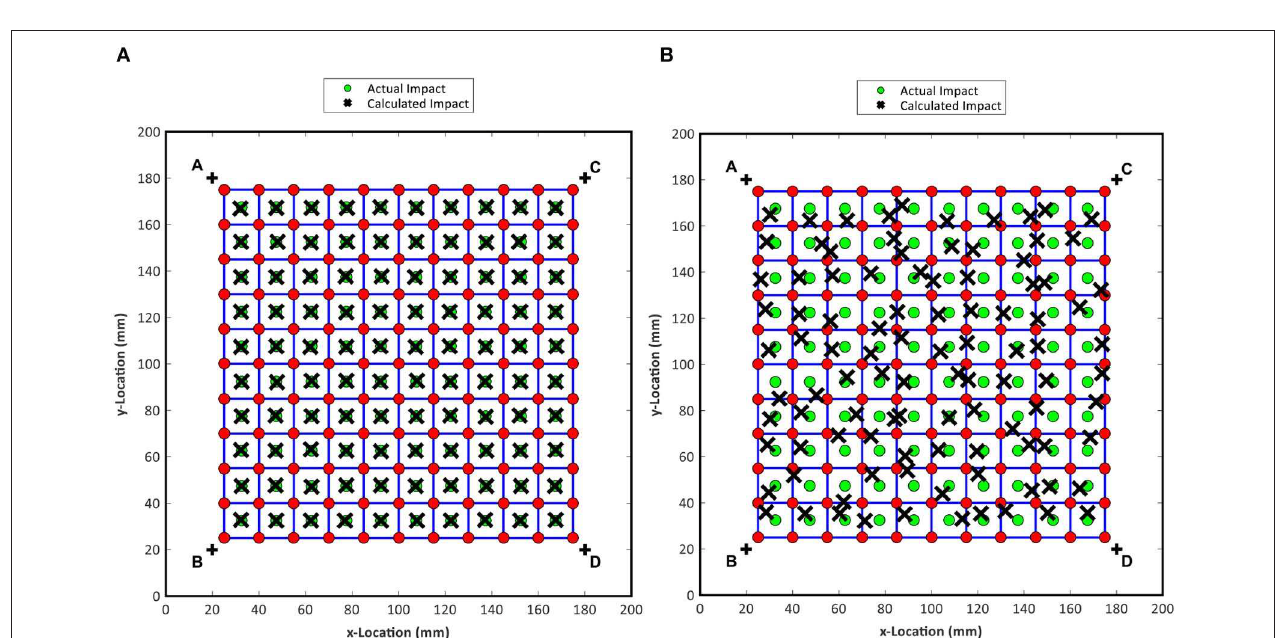
impact locations highlighted by the numbers. It can be observed that the impact points were increased from 100 to 125, and the number of baseline has decreased significantly from 121 to 36 points, by the grid refinement factor 2. After the training process, the original CoG method and the new topological MA approach were applied for a comparison of impact